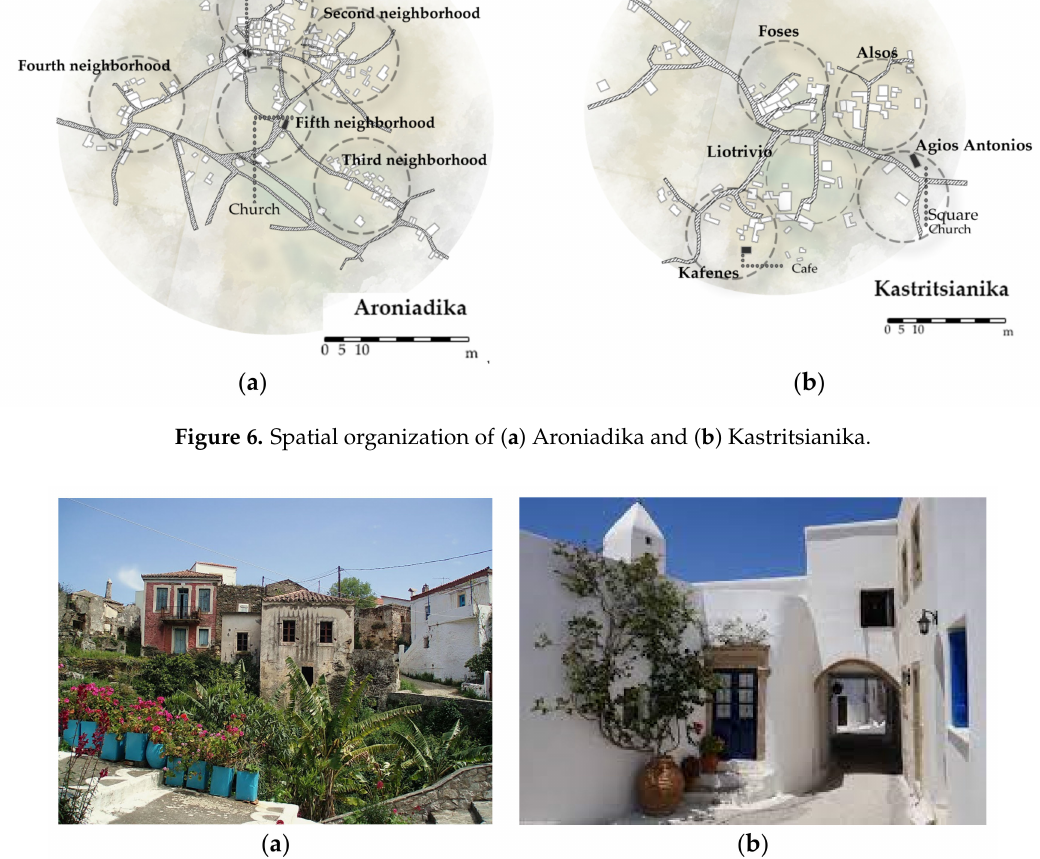
Figure 7. ( a ) Potamos (northern Kythera) and ( b ) Kato Chora (southern